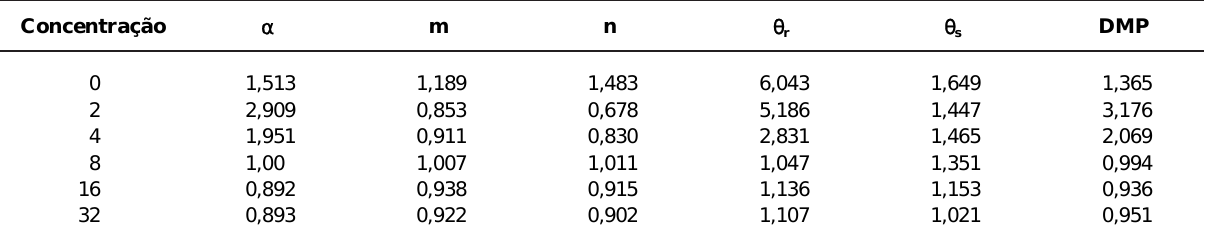
, qqqqq , aaaaa , m, n ; e do DMP entre o Latossolo r s